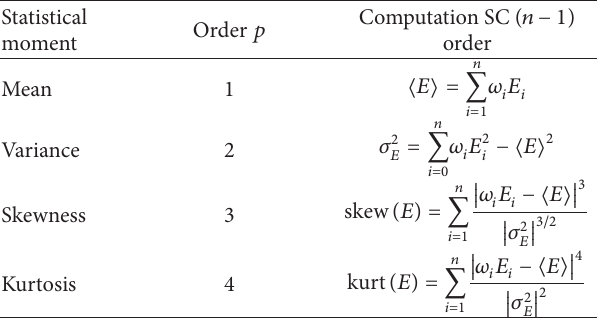
Table 1: SC computation of high-order statistical outputs for the one-RV case (random output 𝐸 ).